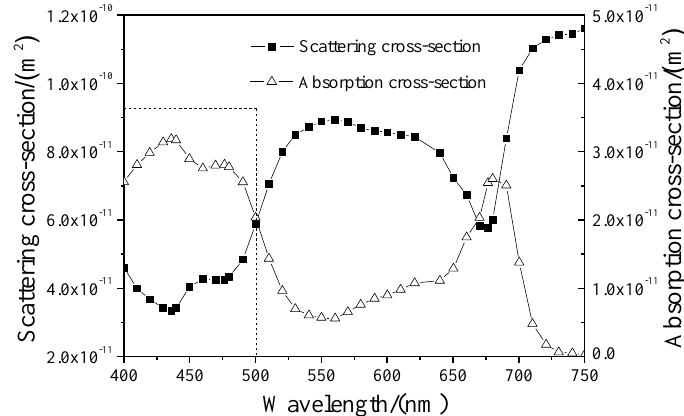
Figure A1. The spectral absorption and scattering cross-sections of C.reinhardtii CC 125 [21].